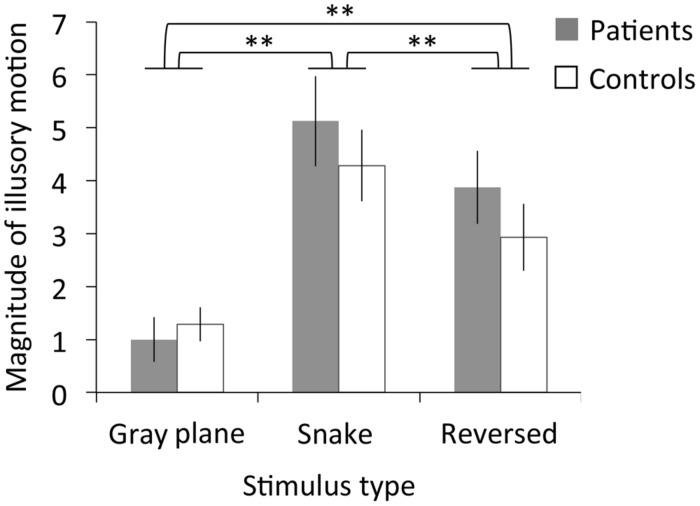
Results of Experiment 2. Magnitude ratings for illusory motion in patients with migraine and normal controls as a function of stimulus type. Error bars denote±1 SEM. Asterisks indicate significant differences (∗∗p < 0.01).